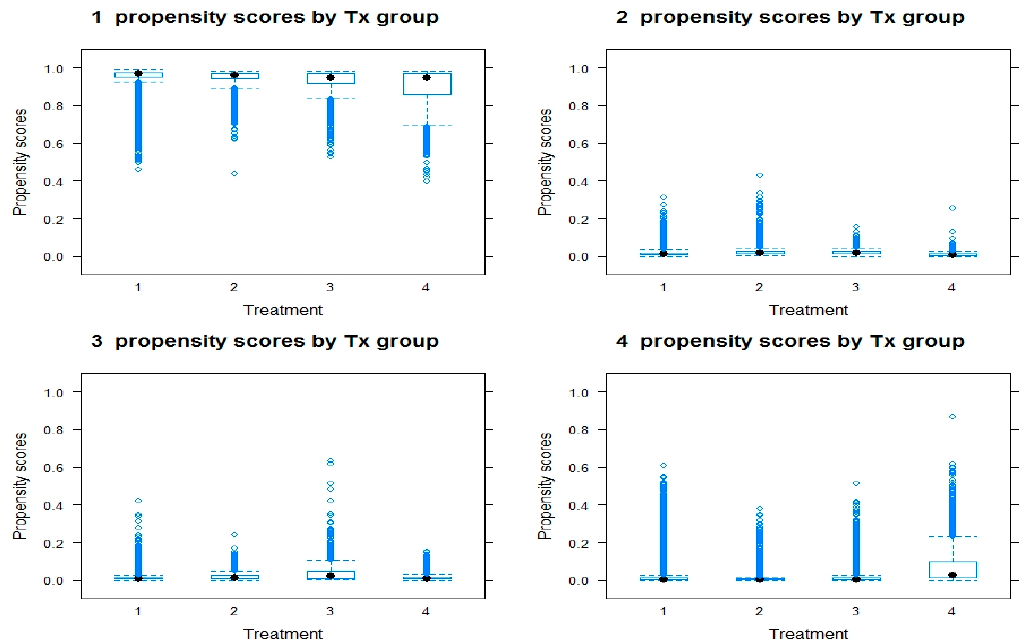
Figure 1. Box plots of propensity scores distribution. 1 = Straight; 2 = Gay / Lesbian; 3 = Bisexual; 4 = Other / Don’t know / Not Sure. Table 3. Logistic regression of being at least overweight (BMI ≥ 25) on sexual identity status and by sex.